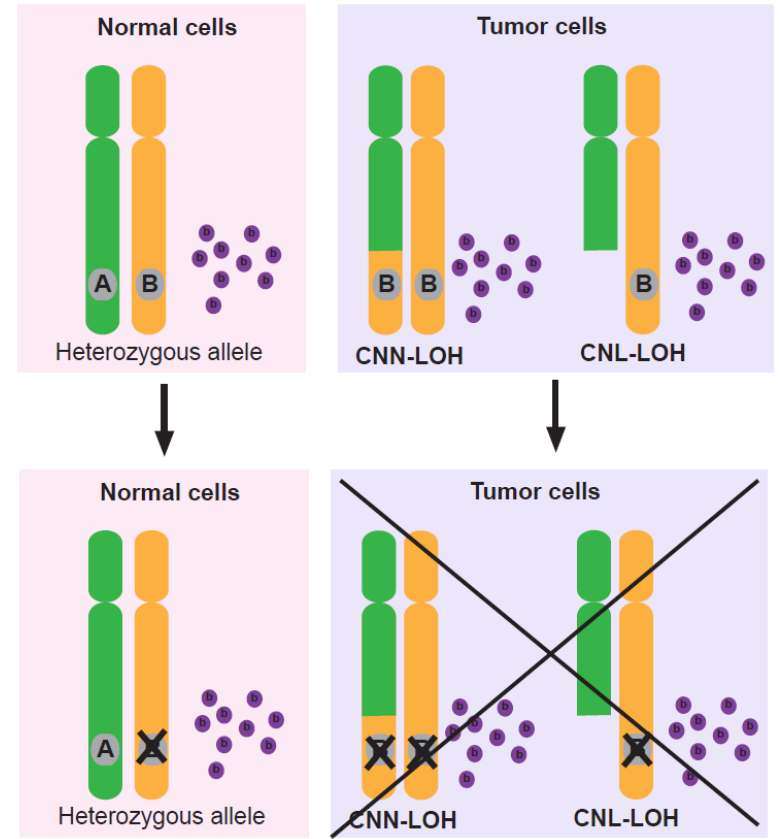
Figure 2. Targeting LOH in tumors for cancer treatment. When a cancer cell undergoes loss of heterozygosity of non-driver genes (A), further loss or inhibition of a specific allele (B) still retained in the tumor should not be tolerated, whereas normal cells will be able to survive relying solely on the retained allele. Treatment with an agent (purple dots) that is either a selective inhibitor of protein product B or a cytotoxic substrate metabolized by A but not B will result in selective killing of the tumor cells. Thus, approaches focusing on non-driver genes represent an alternative target class that merits further exploration. Here, orange and green regions represent either of two homologous chromosomes and ’X’ indicates the selective kill of cancer cells retaining only allele B.